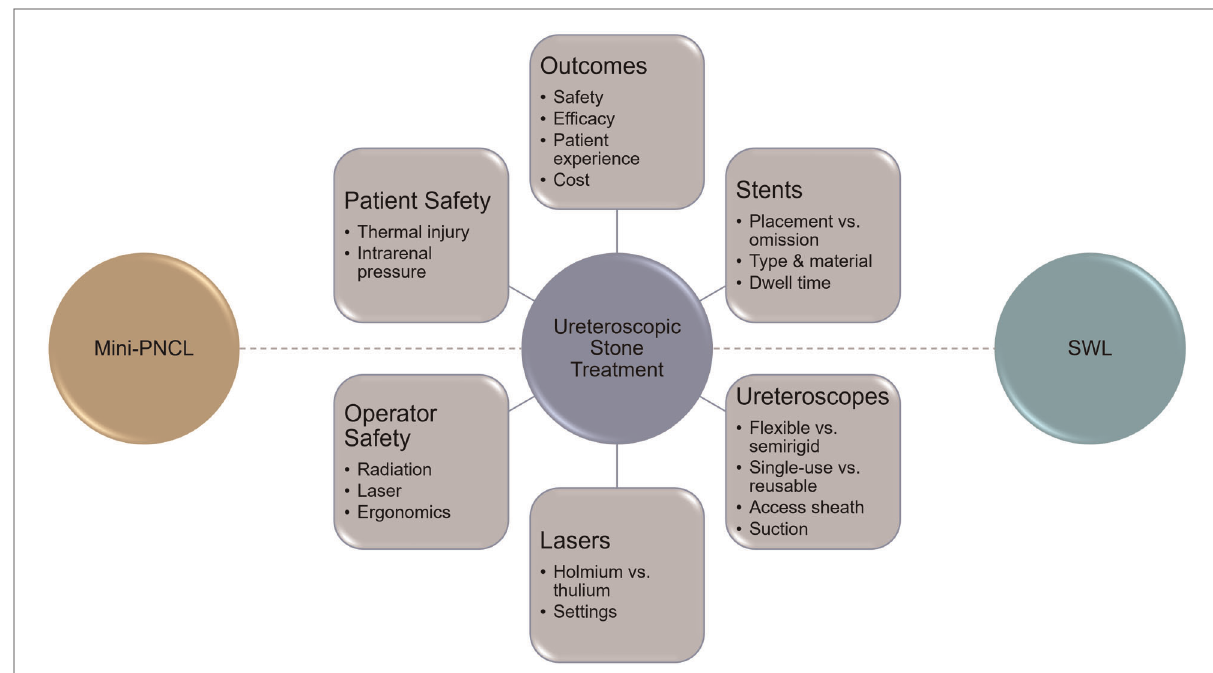
FIGURE 1 Key themes and remaining challenges in ureteroscopic stone treatment. (Mini-PCNL: mini-percutaneous nephrolithotomy; SWL: shockwave